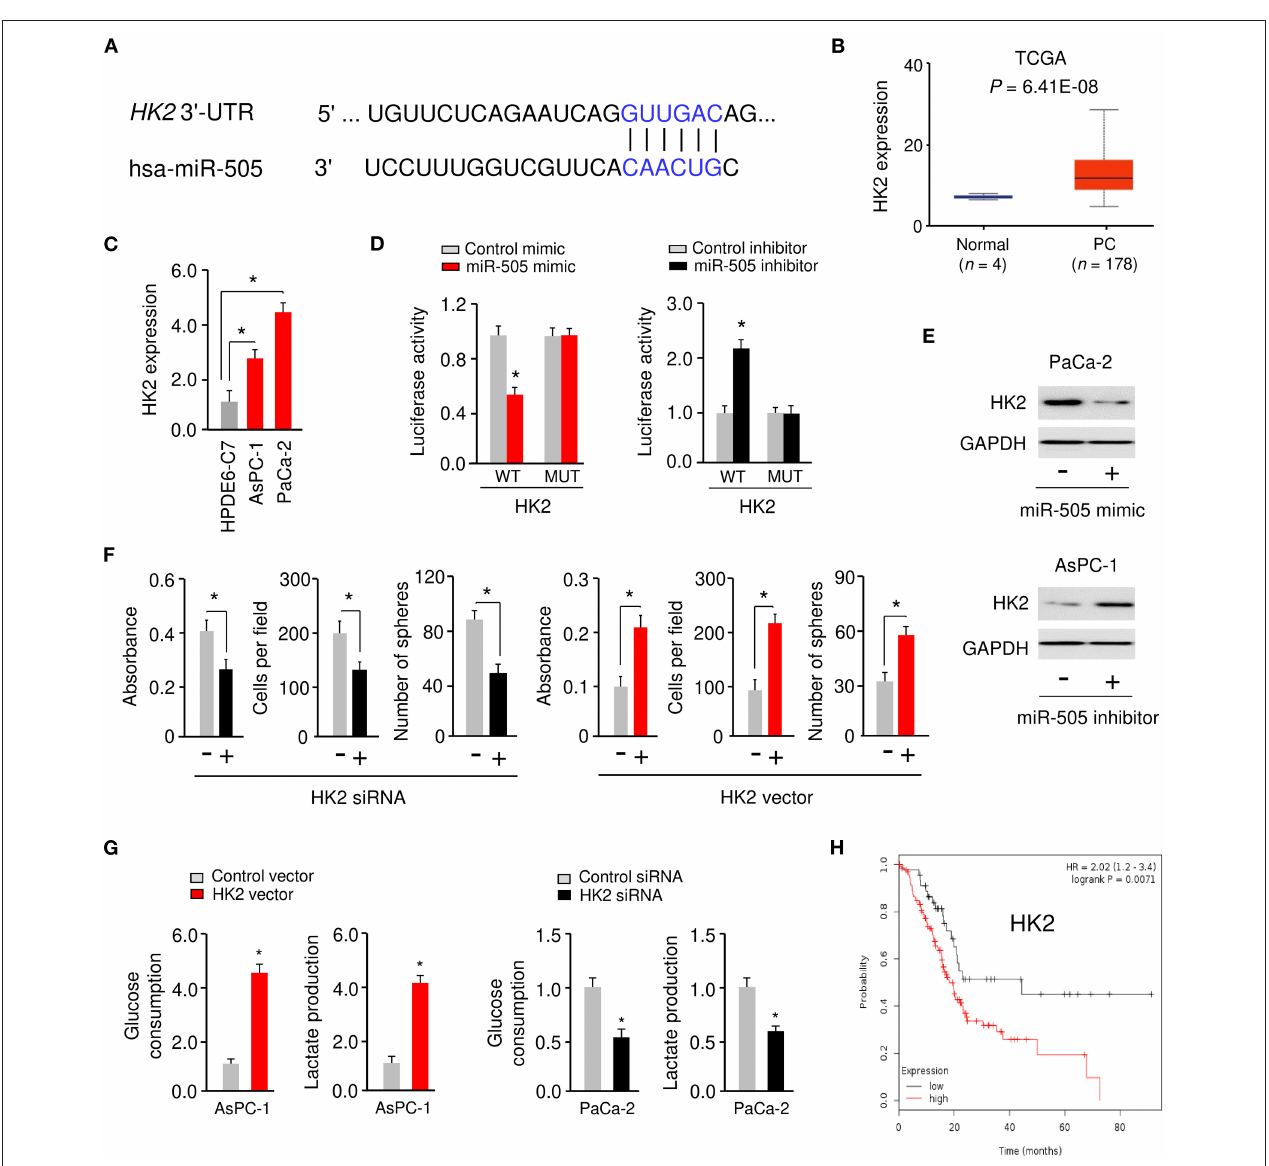
FIGURE 4 | miR-505 directly targets HK2 in PC cells. (A) The predicted miR-505 binding site in the HK2 3 ′ -UTR sequence. (B) The expression of HK2 in PC tissues and normal tissues (UALCAN database). (C) qRT-PCR analysis of HK2 expression in PC cell lines and normal pancreatic cells. (D) PaCa-2 cells were transfected with luciferase reporter vectors containing wild-type (WT) or mutant (MUT) HK2 3 ′ -UTR, along with (or without) miR-505 mimic, and AsPC-1 cells were transfected with luciferase reporter vectors containing WT or MUT HK2 3 ′ -UTR, along with (or without) miR-505 inhibitor. The binding between miR-505 and HK2 was verified using luciferase reporter assays. (E) Western blotting analysis of HK2 expression in PaCa-2 cells transfected with (or without) miR-505 mimic, and in AsPC-1 cells transfected with (or without) miR-505 inhibitor. (F) PC cells were transfected with HK2 vector or HK2 siRNA as indicated, and cell proliferation, invasion and sphere formation assays were performed. (G) Glucose consumption and lactate production assays in PaCa-2 cells after knockdown of HK2 and in AsPC-1 cells after overexpression of HK2. (H) Kaplan-Meier curves for the overall survival of PC patients were compared between groups with high or low levels of HK2 based on the TCGA data from the KM Plotter database. * P <